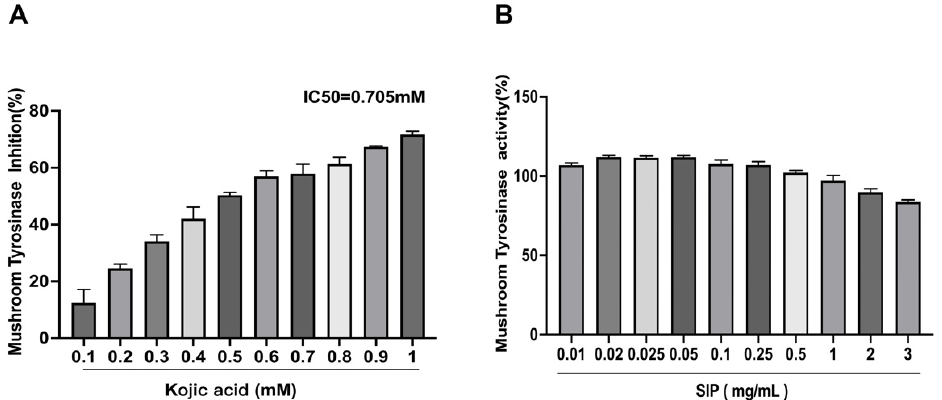
Figure 2. Effect of SIP and positive control kojic acid on mushroom tyrosinase activity. ( A ) Tyrosinase inhibitory effect of kojic acid using L-DOPA as substrate. ( B ) The effect of SIP on tyrosinase activity using L-DOPA as substrate. Results were presented as the mean ± SD ( n = 6).